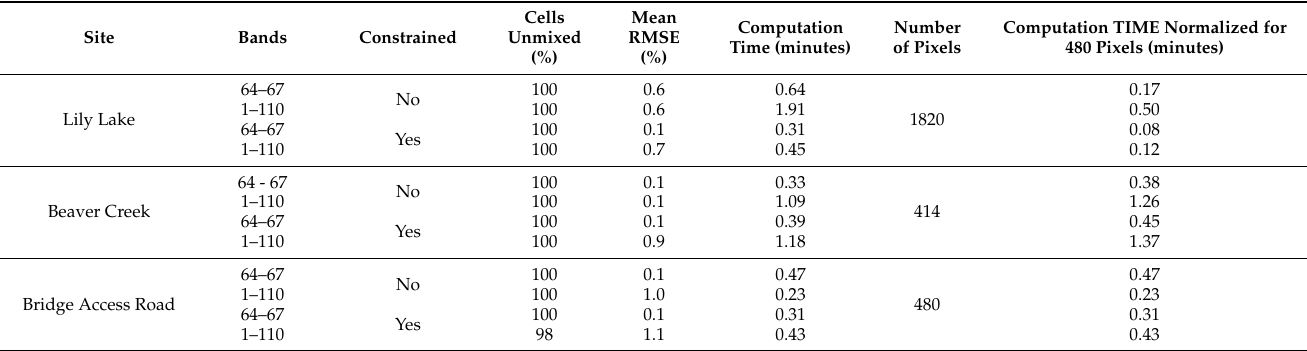
Table 6. Comparison of the statistical results for PFT constrained and unconstrained MESMA for the small, predicted swaths of the three wetland sites using both the 4-band and 110-band IES- pruned